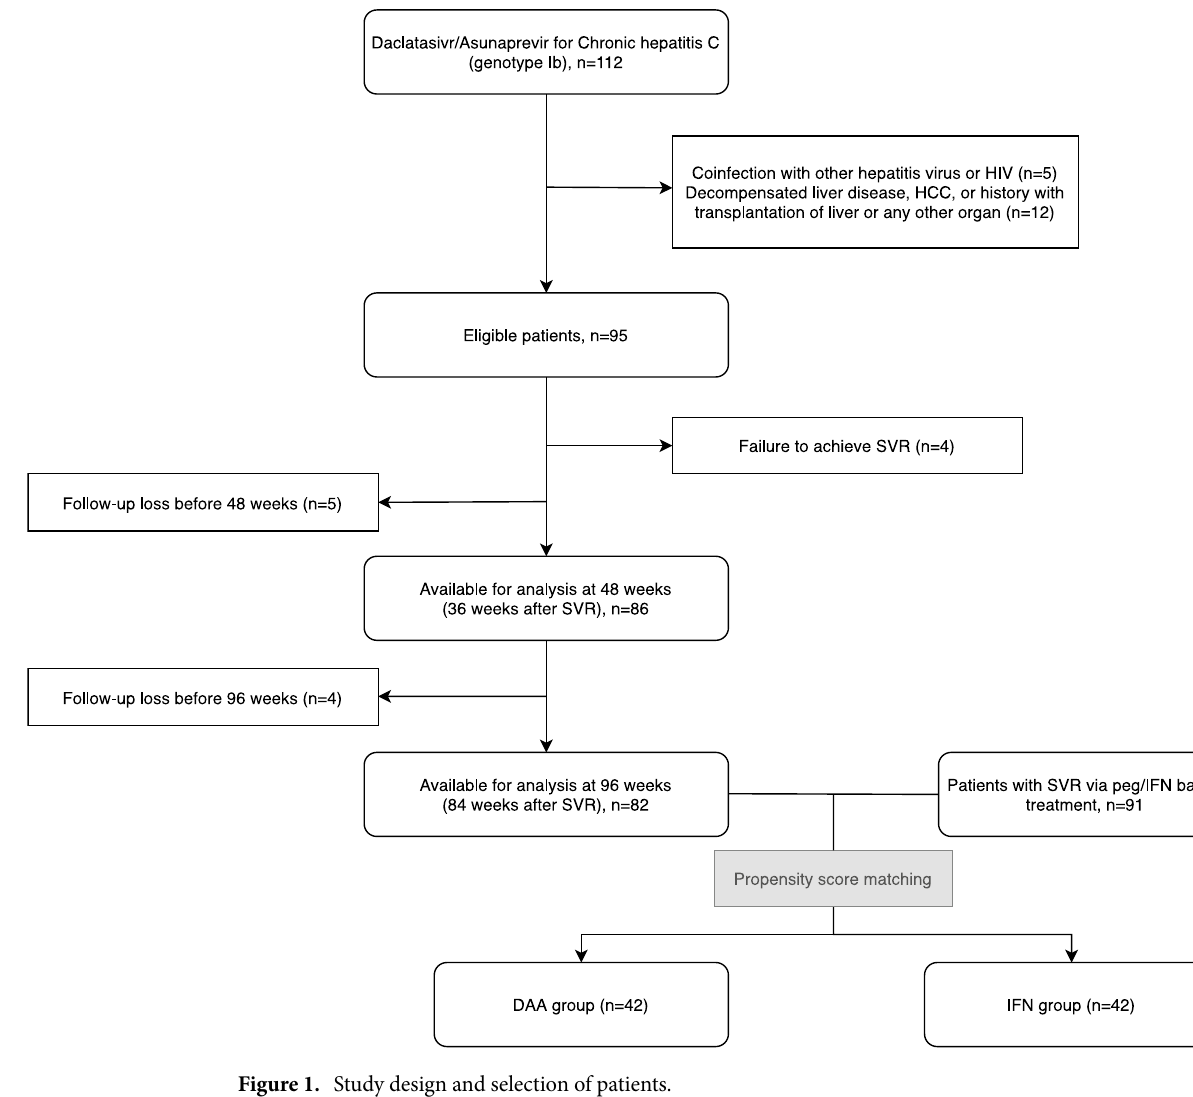
Figure 1. Study design and selection of